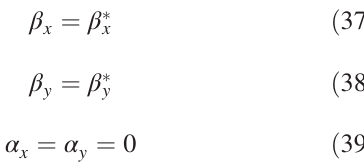
ffiffiffiffi p N ). Since the